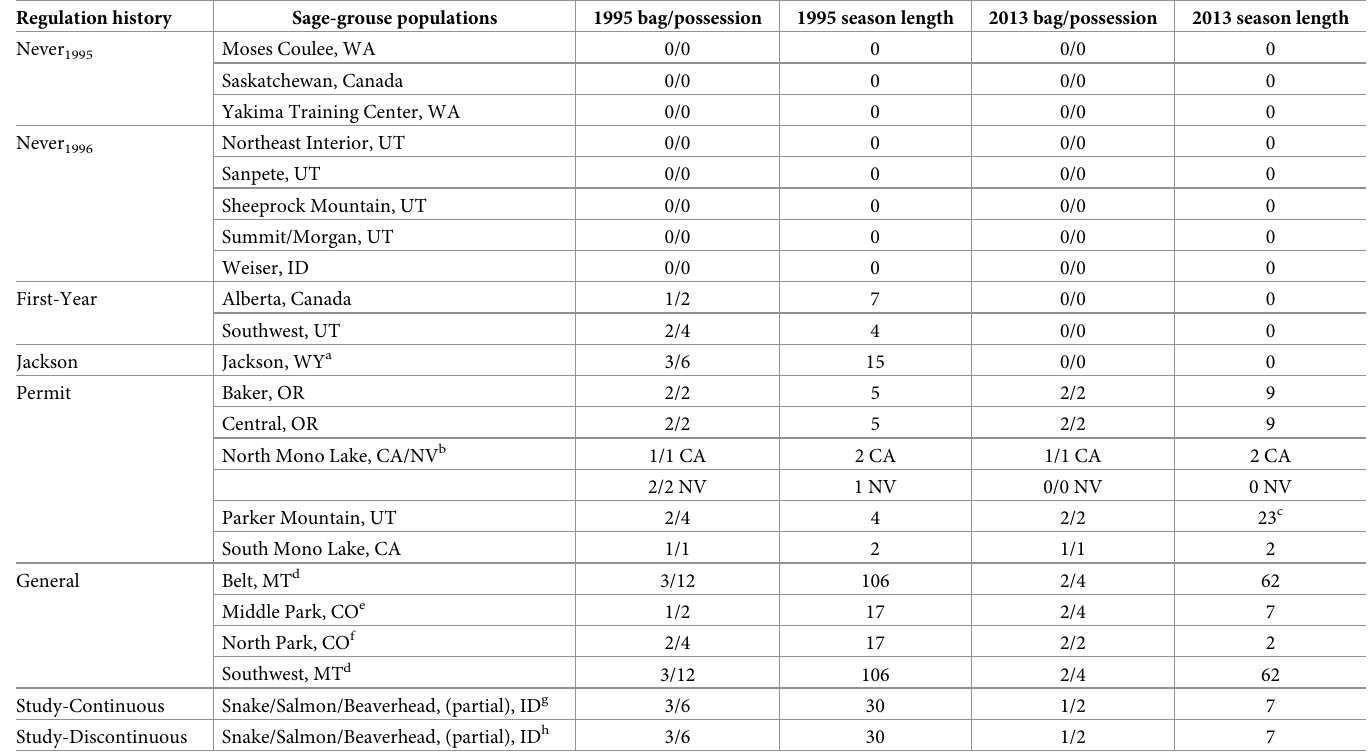
Table 2. Hunting regulations stratified by regulation history and sage-grouse population. Bag/possession limits and season lengths (days) represented harvest expo- sure for sage-grouse. Data from western U.S. and southern Alberta and Saskatchewan Canada from 1995–2013. Footnotes highlight major changes to hunting regulations between 1995 and